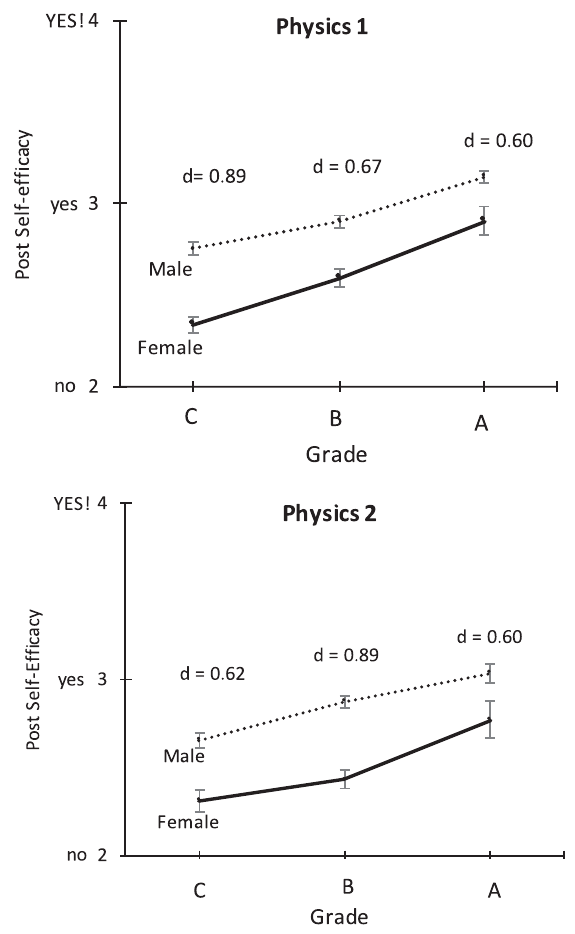
FIG. 2. Post-self-efficacy scores of female and male students binned by course grade (A, B, C) in physics 1 (top) and physics 2 (bottom) courses. Error bars represent standard error of the mean.